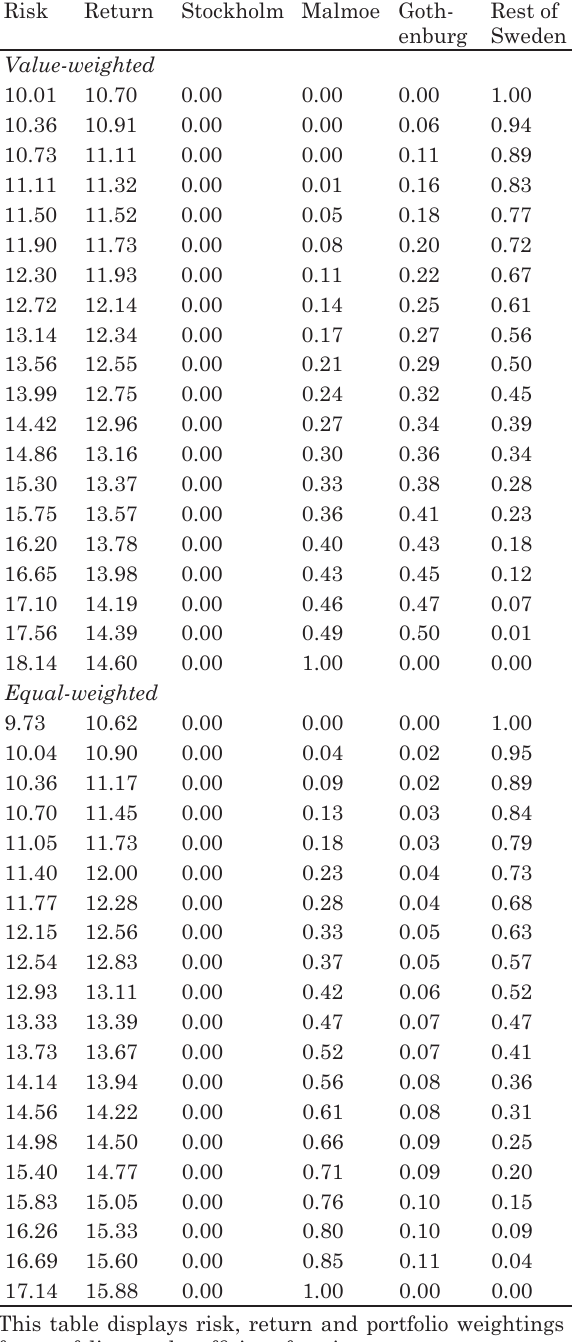
Table 9. Portfolio weightings for twenty points on the efficient frontier for value- and equal-weighted region